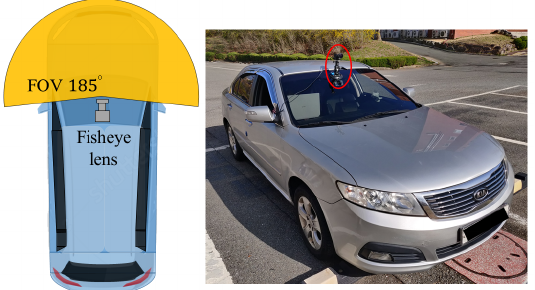
Figure 5. Fisheye camera installed on the front window of a test